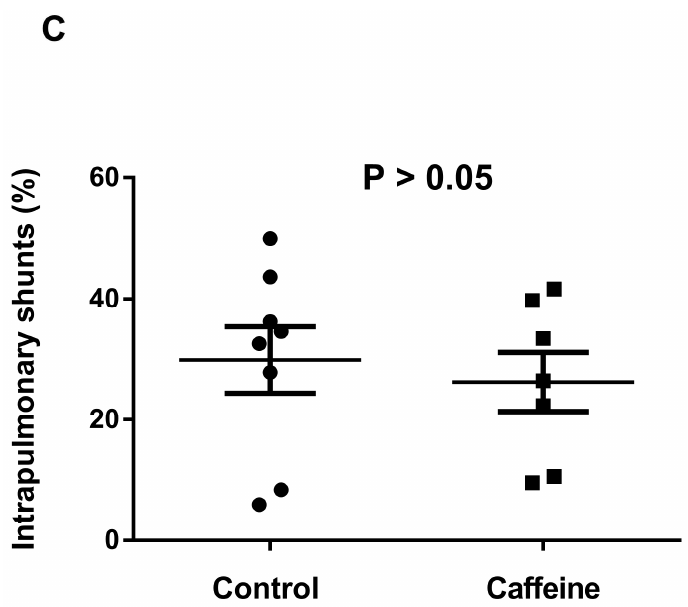
Figure 2. ( A ) Pulmonary histology and immunochemical staining of CBDL rats treated by caffeine or distilled water. The representative H&E staining image depicts prominent polymorphonuclear cells infiltration ( green arrow ) in control and caffeine-treated rats (magnification 100x, upper panel). Caffeine does not diminish vWF-positive staining cells ( green arrow indicating brown cell; magnification 200x, middle panel ) as compared to the control rats. Also, the CD68-positive staining cells are not attenuated by caffeine ( green arrow indicating brown cell; magnification 200x, lower panel ). ( B ) Pulmonary protein expressions of caffeine-treated and control CBDL rats. The densitometric quantification and representative Western blots of VEGF, Rho-A kinase and PI 3 K are similar between caffeine-treated and control groups ( upper panel ). The phosphorylated-NF- κ B p65, phosphorylated-ERK(42/44), and phosphorylated-Akt protein expressions are not significantly influenced by caffeine ( lower panel ). The representative Western blots are shown. ( C) Degrees of pulmonary shunting in caffeine-treated and control CBDL rats. The shunting degrees are similar between the two groups ( p > 0.05).